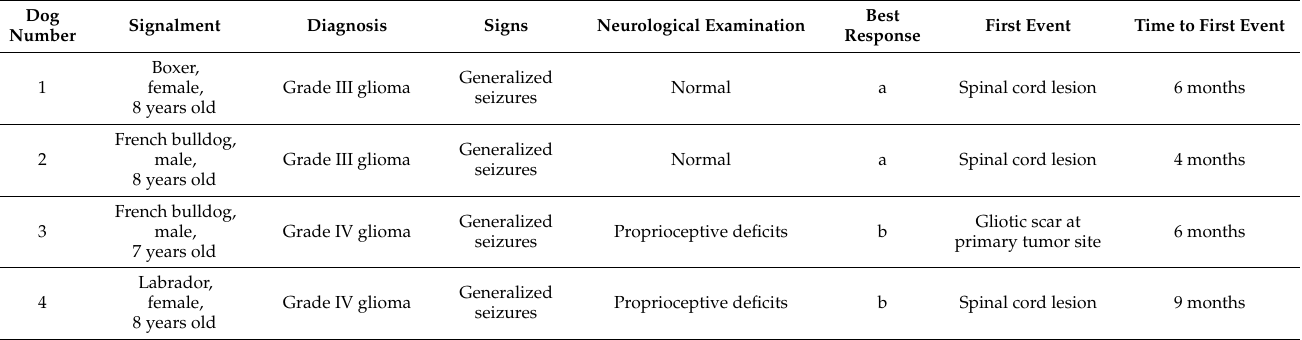
Table 1. Signalment and main clinical